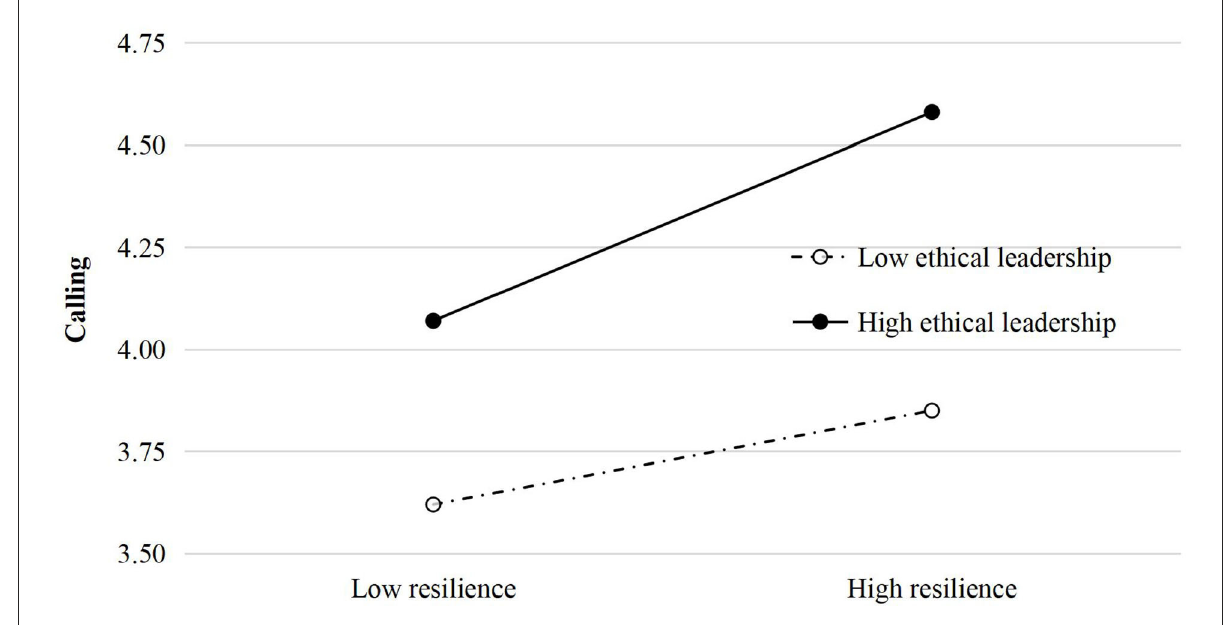
FIGURE2 Moderating effect diagram of ethical leadership.